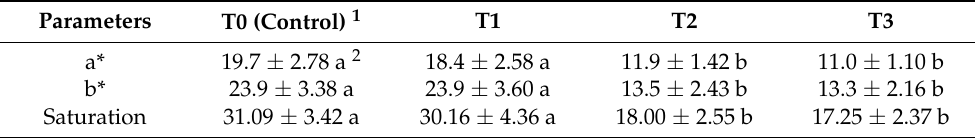
Table 7. Influence of growing media on colour parameters of marketable tomato fruits.